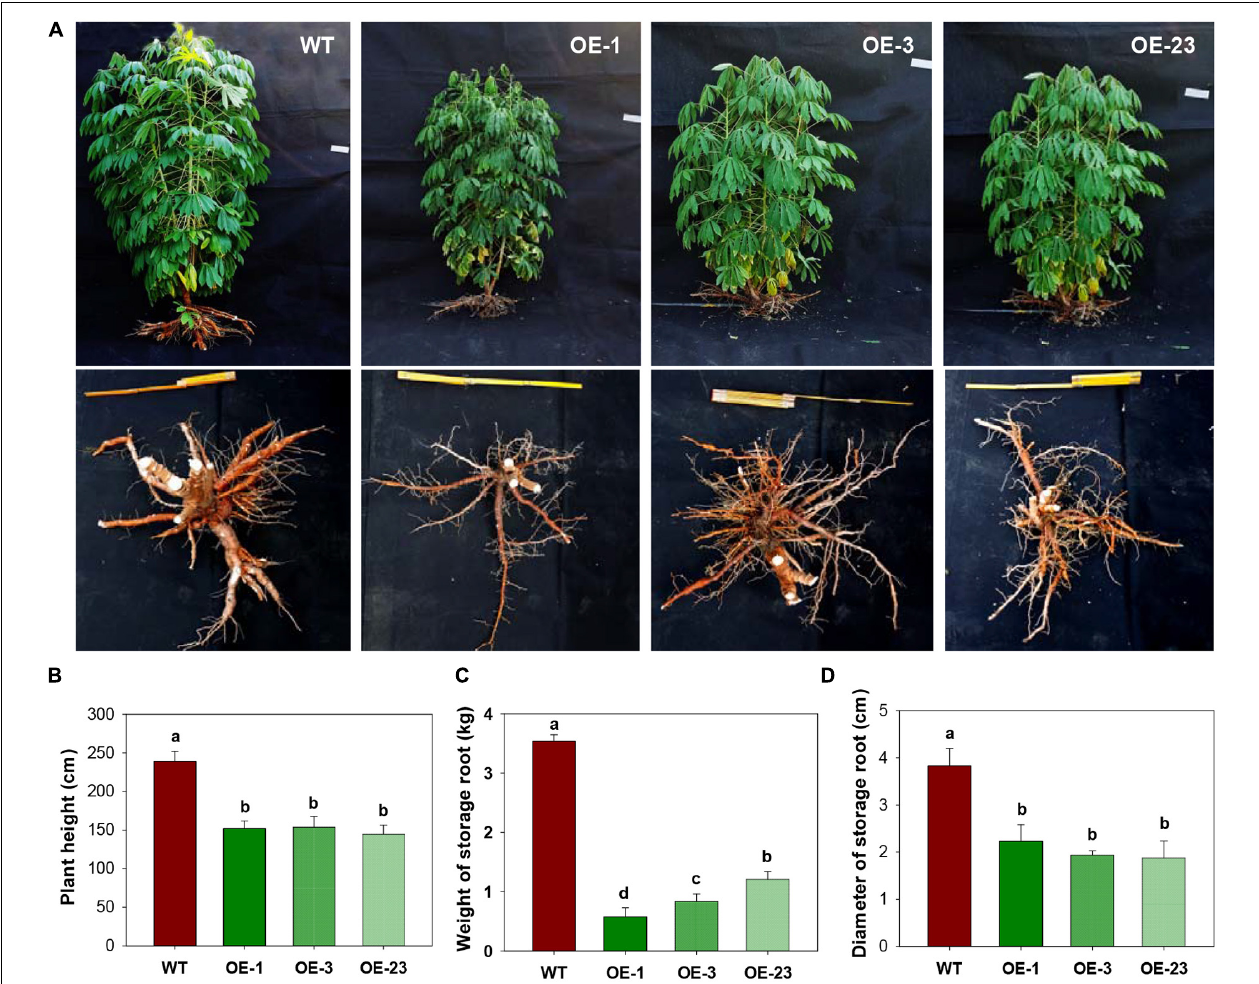
FIGURE 3 | Field performances of transgenic cassava plants overexpressing MeCWINV3 . (A) Whole-plant phenotype of wild-type (WT) and transgenic (OE lines) cassava plants. (B–D) Plant height (B) , storage root yield and (C) , and storage root diameter (D) of WT and transgenic plants. Different letters indicate significant differences (one-way ANOVA, p <